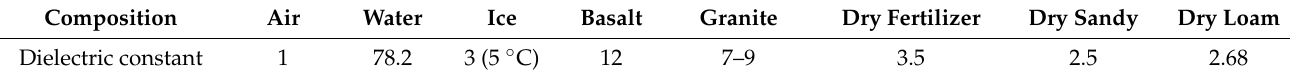
Table 1. The dielectric constants of the main components of soil.